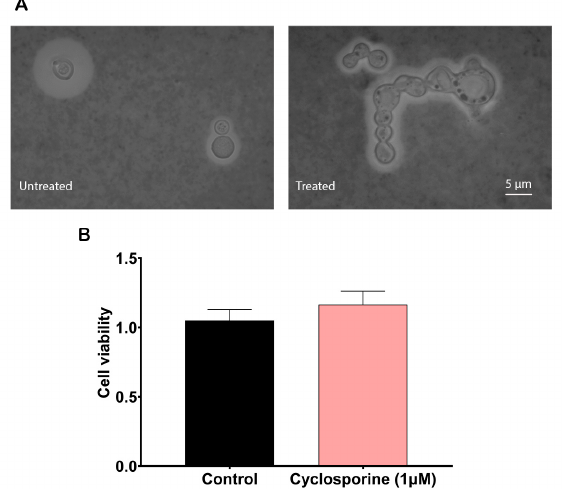
Figure 1. Effects of cyclosporine on cryptococcal cells. ( A ) Morphological alterations of C. neoformans induced by cyclosporine. Yeasts were stained with Indian ink to show their polysaccharide capsules. Scale bar: 5 µm. ( B ) Effect of cyclosporine on the metabolic activity of C. neoformans , measured using the XTT test. Statistical significance was determined via a t-test, which did not find statistical differences ( p -value = 0.1778).